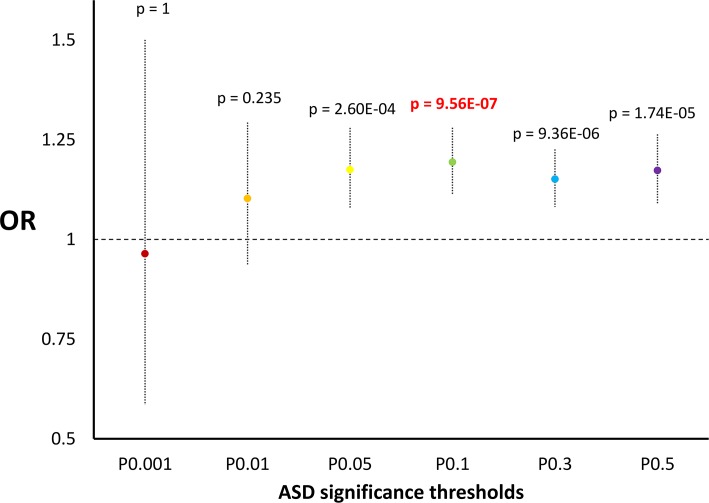
Enrichments for scores related to incomplete selection in ASD GWAS considering different thresholds.Odds Ratio, 95% confidence interval, and p value is reported for each threshold investigated.